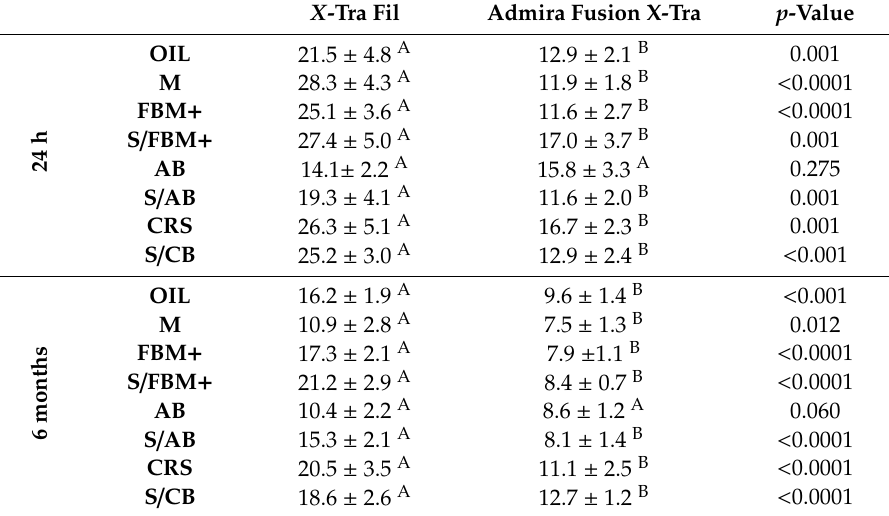
Table 4. Mean ± standard deviation for the e ff ect of material within each surface treatment and storage time on µ